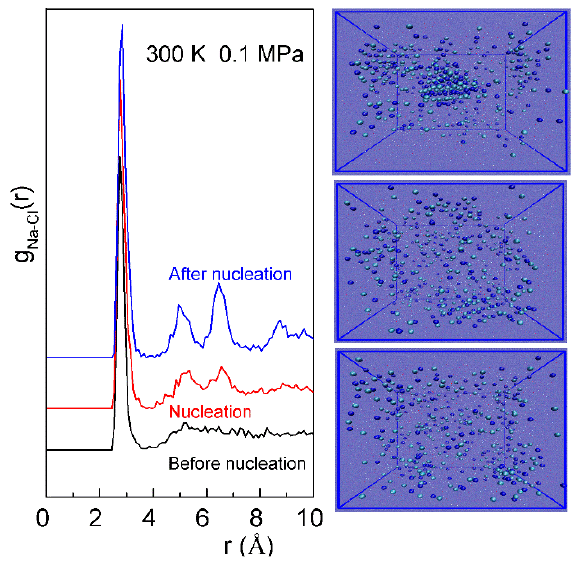
Figure 5. The g Na-Cl(r) of NaCl solutions (NaCl:H 2 O = 223:2000) in the process of nucleation. The corresponding configurations are also shown (from bottom to top).